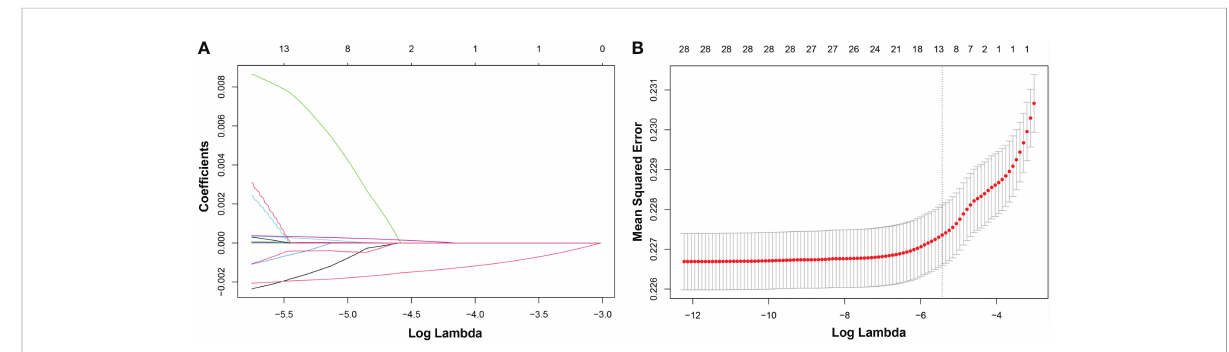
FIGURE 4 LASSO regression analysis to screen key dietary factors most related to hypertension. (A) Plot for LASSO regression coef fi cients. (B) Cross- validation plot. LASSO, least absolute shrinkage and selection operator.